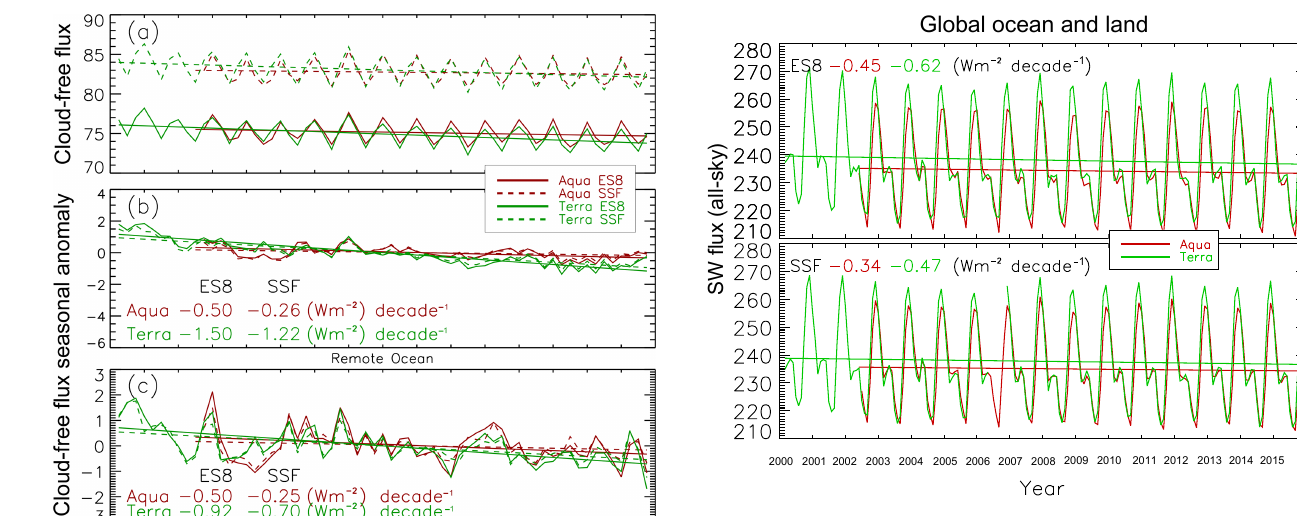
Figure 9. Time series of all-sky SW flux over the entire globe (land and ocean). The trends are calculated from monthly and globally averaged all-sky SW fluxes derived from the CERES SSF/ES-8 data. SW fluxes from all scenes including cloudy, clean, land and ocean are taken into account when calculating the monthly aver- ages, which are gridded into a similar resolution as the collocated MODIS–CERES dataset (2 ◦ × 2 ◦